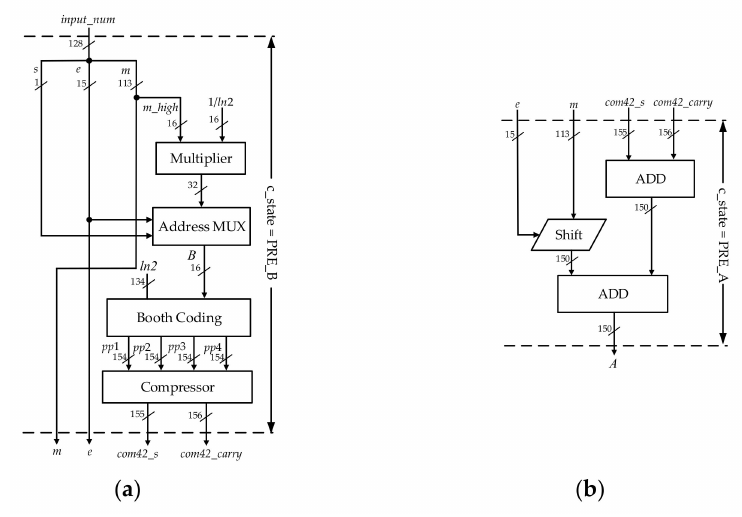
Figure 5. ( a ) Architecture of state PRE_B; ( b ) architecture of state PRE_A. State INIT is to perform the initialization process of exponential function e input_num .